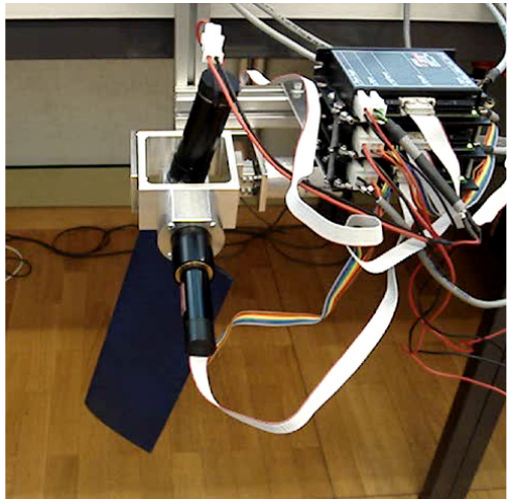
Figure 9. Hydrofoil and mechanical propulsion